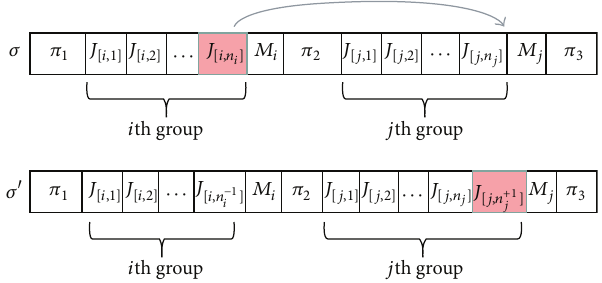
Figure 1: The illustration of the moving of job 𝐽 [𝑖,𝑛